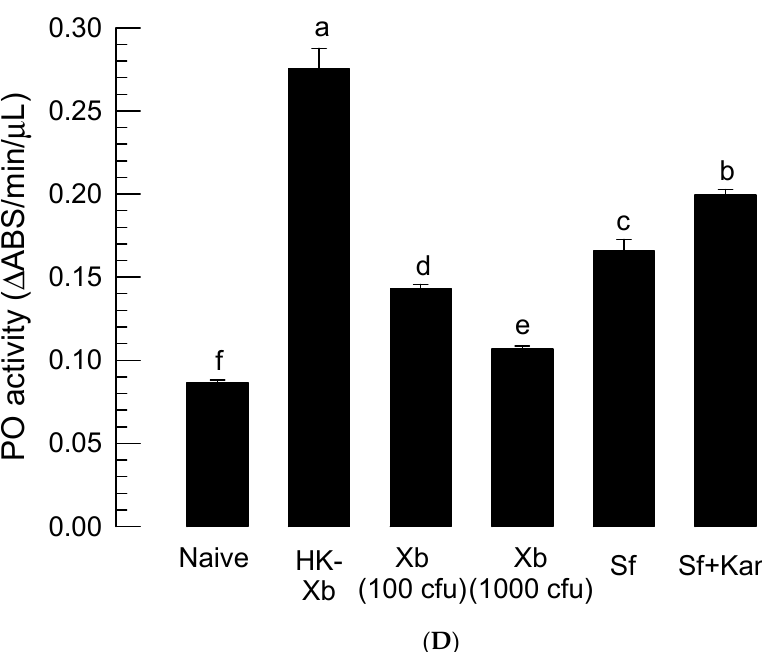
Figure 7. Independent roles of nematode and its symbiotic bacteria of S. feltiae K1 (‘Sf’) in their pathogenicity against P. xylostella . ( A ) Screening effective antibiotics against X. bovienii SS2004 growth using inhibition zone assay. Kanamycin (‘Kan’), tetracyclin (‘Tet’), and ampicillin (‘Amp’) were screened. ( B ) In vivo effect of Kan (0.1 µg/larva) on bacterial growth in P. xylostella larvae treated with 80 IJs of S. feltiae K1 per larva. Antibiotics treatment was performed just before the nematode treatment. Bacterial colonies were counted at 8 h after nematode treatment and expressed as colony forming units (cfu) per mL of hemolymph. Photos above the graph demonstrate bacterial colonies in each treatment. ( C ) Rescue effect of Kan (0.1 µg/larva) on larvae treated with 80 IJs of S. feltiae K1 per larva. Two different concentrations of X. bovienii (‘Xb’) were injected to hemocoel of P. xylostella larvae. Each treatment was replicated three times. Each replication used 10 larvae. ( D ) Rescue effect of Kan (0.1 µg/larva) on phenoloxidase (PO) activity of the larvae treated with 80 IJs of S. feltiae K1 per larva. Heat-killed X. bovienii (‘HK-Xb’) was injected to larvae at a concentration of 1000 cells per larva. PO activity was measured at 8 h post infection. Each treatment was replicated three times. Different letters above standard error bars indicate significant difference among means at Type I error = 0.05 (LSD test).